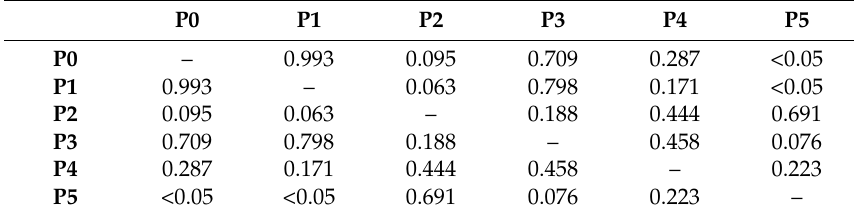
Table 5. p -Value between each period analysed for anaerobic exercise.